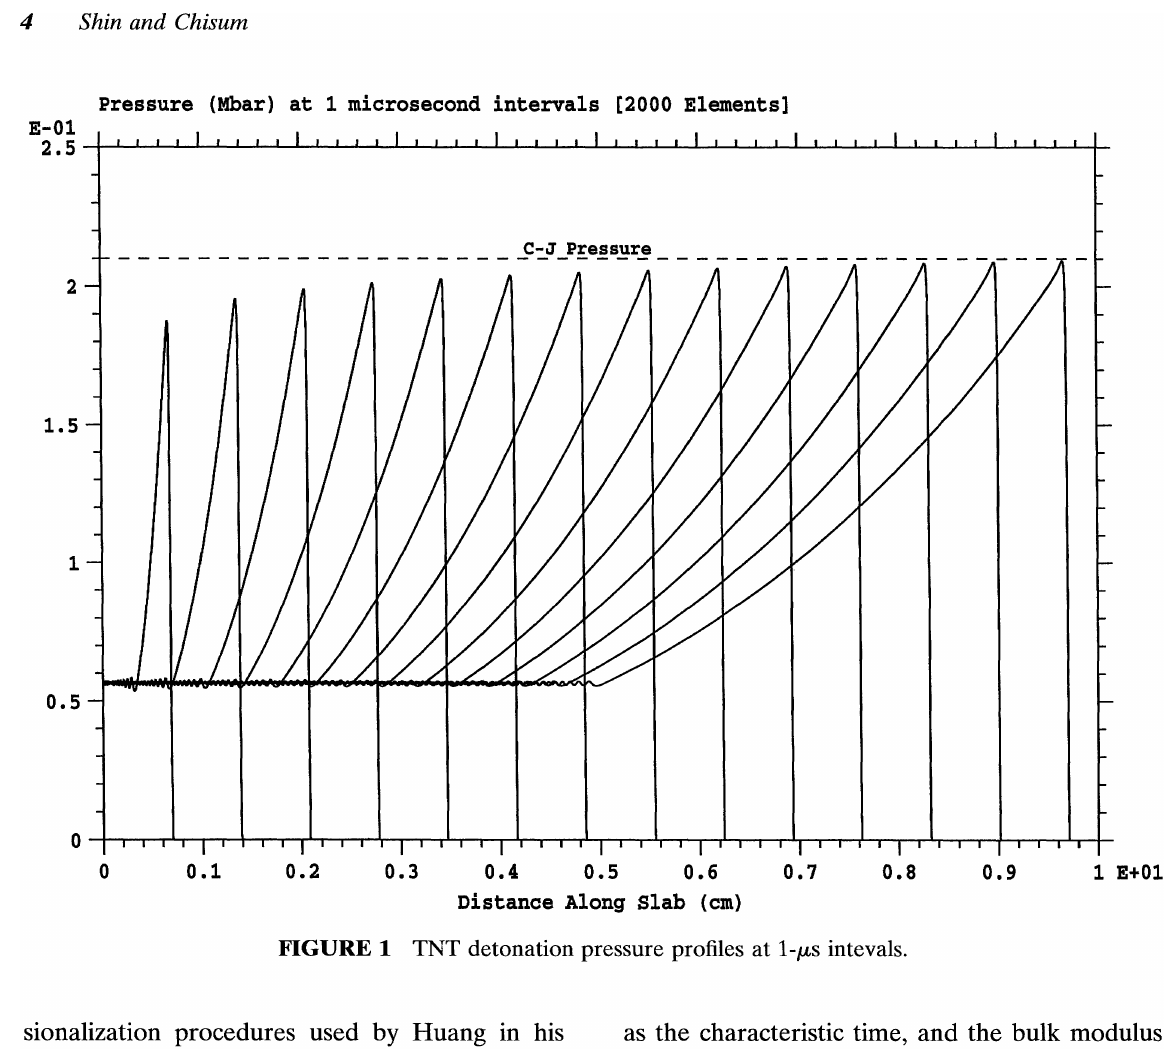
FIGURE 1 TNT detonation pressure profiles at l-lLs